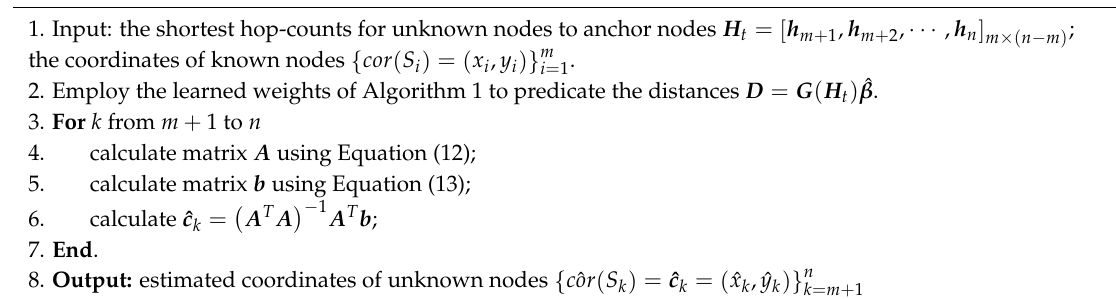
Algorithm 2. Location